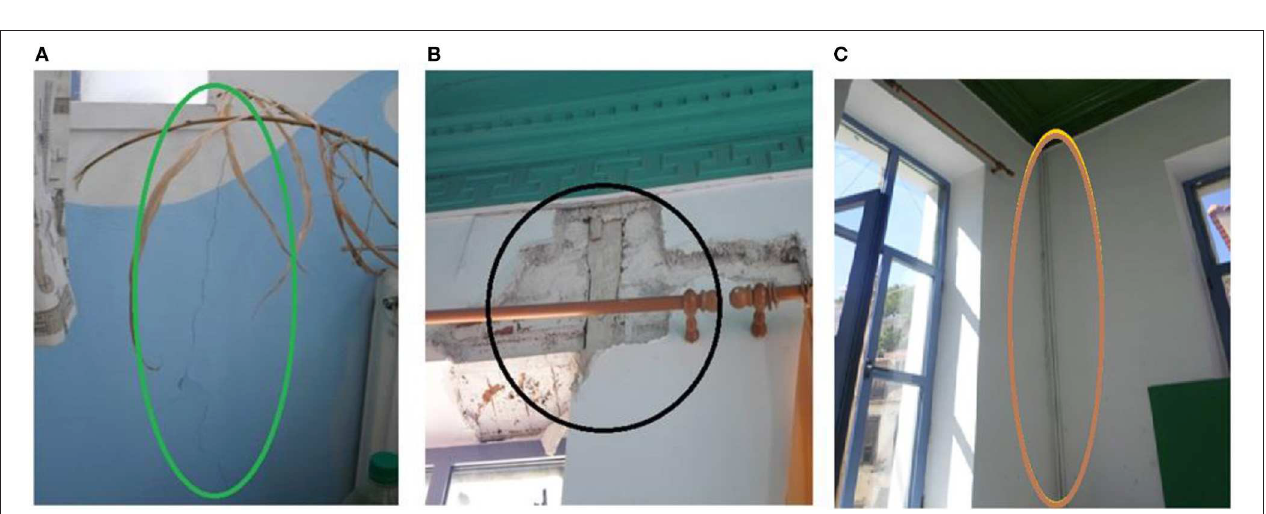
FIGURE 8 | Damages recorded during the site visit. (A) Crack due to out of plane bending of the masonry wall. (B) Stress concentration under in plane bending of the masonry wall. (C) Crack attributed to poor connection between the intersecting walls.